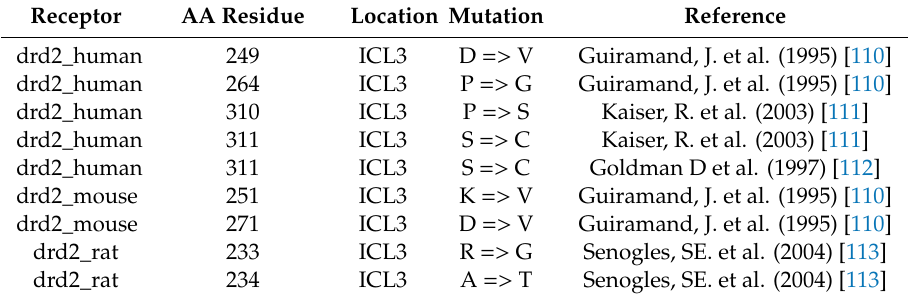
Table 3. A summary of mutations within the ICL3 of the D 2 -R (source: G protein-coupled